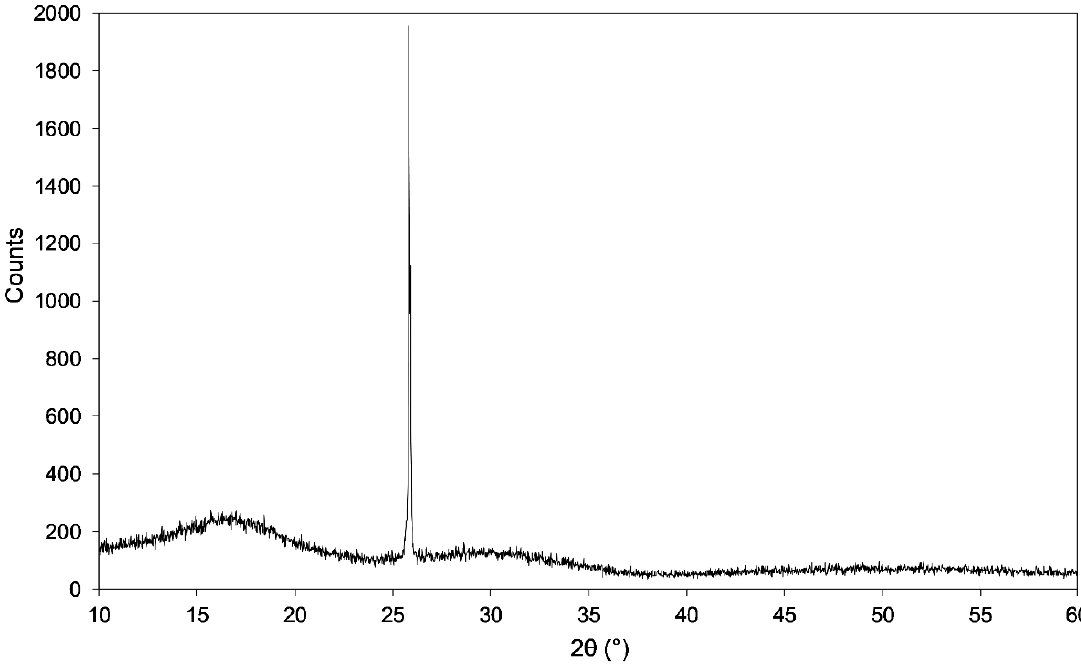
Figure 6. Broad X-ray beam scan of a slice of betafite partially embedded with a single grain of apatite. The discrete peak at ≈25.8° 2θ is consistent with the 002 peak from indexed apatite patterns from the PDF-2 database (PDF 15-0876). Additional apatite peaks are not represented in these diffraction data due to the singular orientation and monocrystalline nature of the embedded apatite. No discrete peaks associated with pyrochlore or any other mineral are present in our broad X-ray beam data.